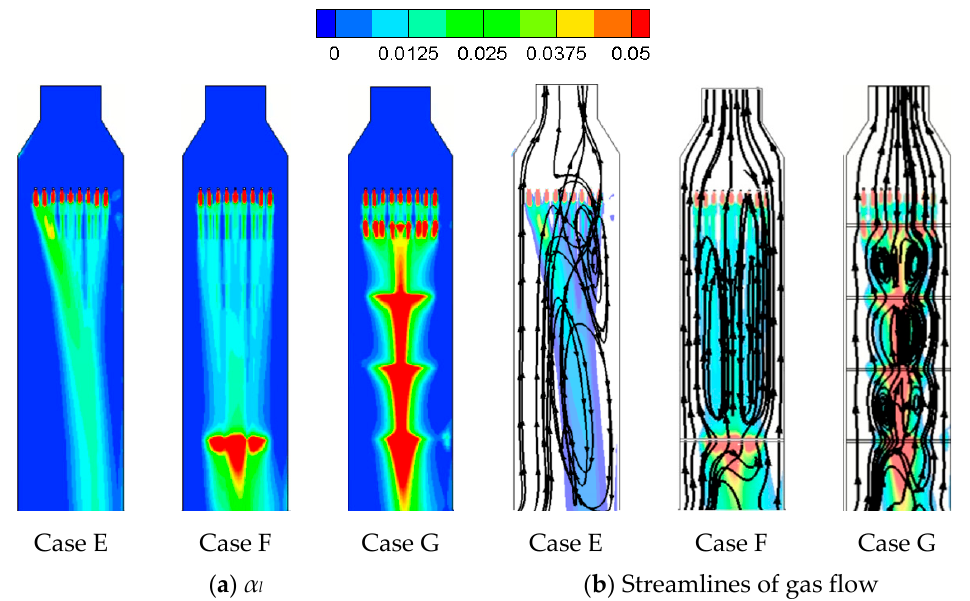
Figure 17. The figure displays ( a ) the liquid volume fraction and ( b ) streamlines of gas flow for Case E–Case